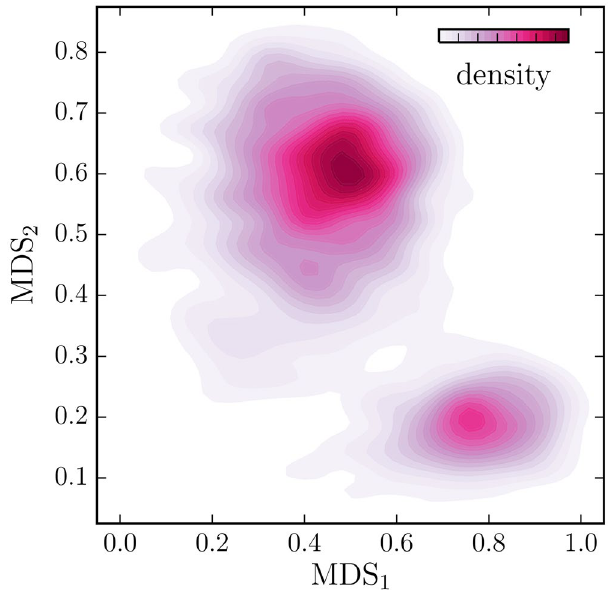
Figure 3. Conformational space of the camphor migration along pw2 in the proximity to the putative substrate recognition site of cytochrome P450cam retrieved using the multidimensional scaling. The conformations of the enzyme are split into the open ({0.5, 0.6}) and closed ({0.8, 0.2}) states. For the clustering of these conformers into the well-defined collections see Figs S2–S5 of the Supplementary